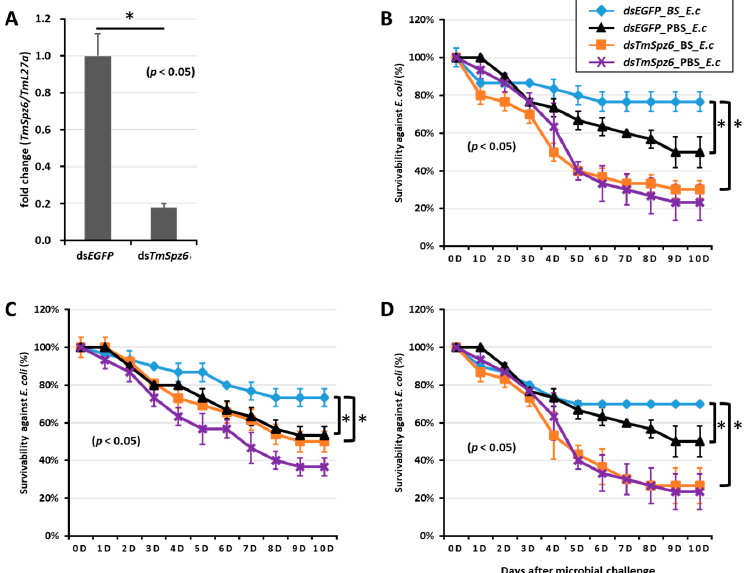
Figure 10. Survivability of T. molitor larvae against E. coli (E.c) after TmSpz6 gene silencing and